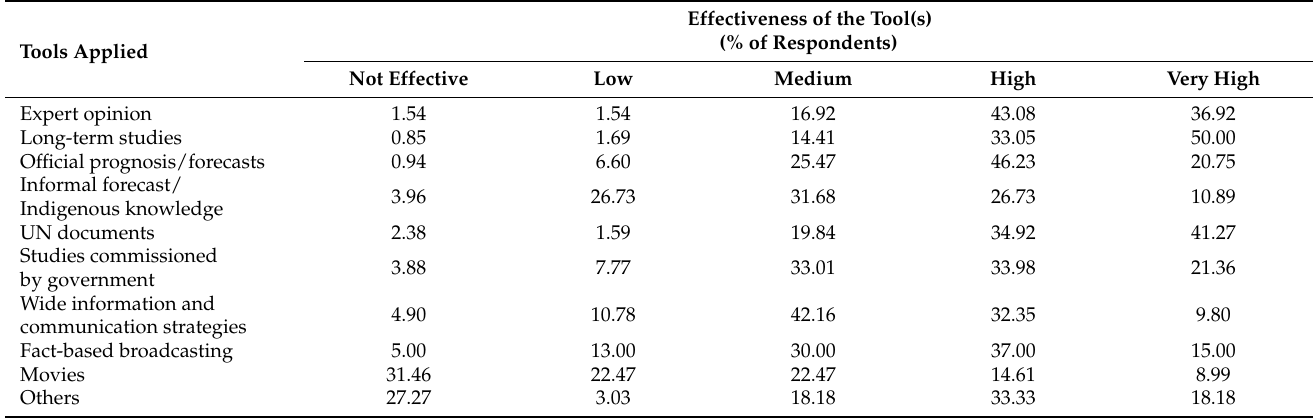
Table 5. Importance of tools used to reduce uncertainty in climate change decision